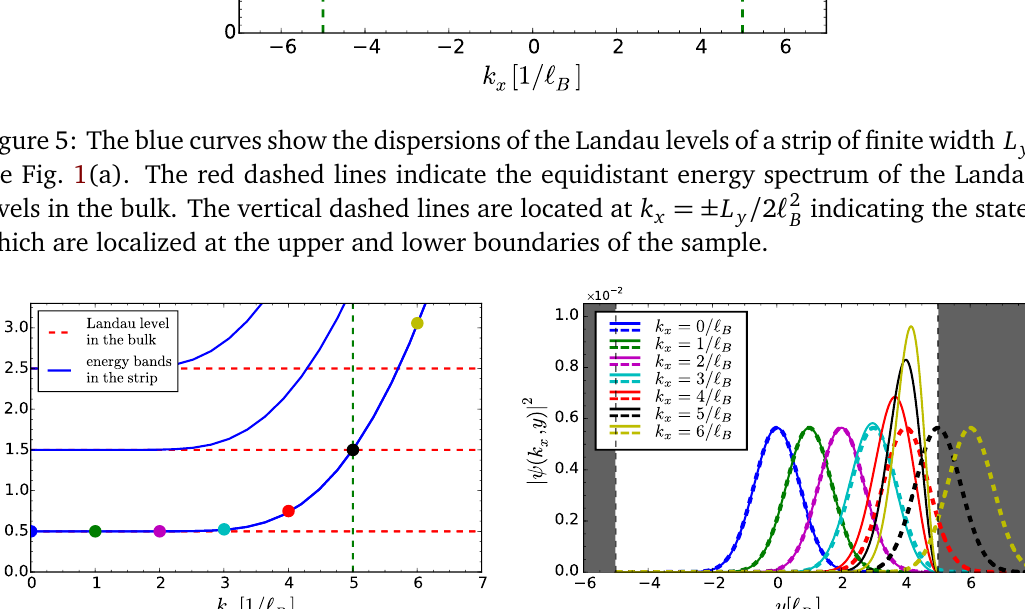
Figure 6: Left panel: Zoom of the dispersion bands in the IQHE. The vertical dashed green = L / 2 (cid:96) 2 line is located at k marking the boundary of the sample. The colored dots indi- x y B cate the eigen energies of the corresponding eigen wave functions. Right panel: Probability densities | ψ ( k , y ) | 2 of these eigen wave x